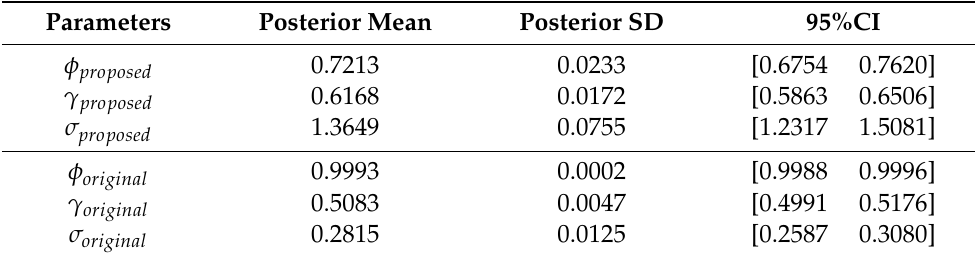
Table 34. Comparison of estimated parameters (27 July 2016, TMC, Aichi, Japan).